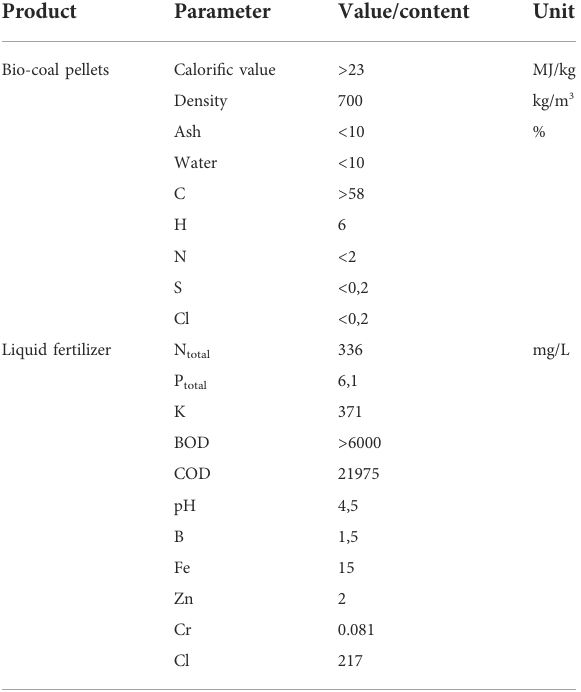
TABLE 2 Composition of products of hydrothermal carbonization methods of post-fermentation